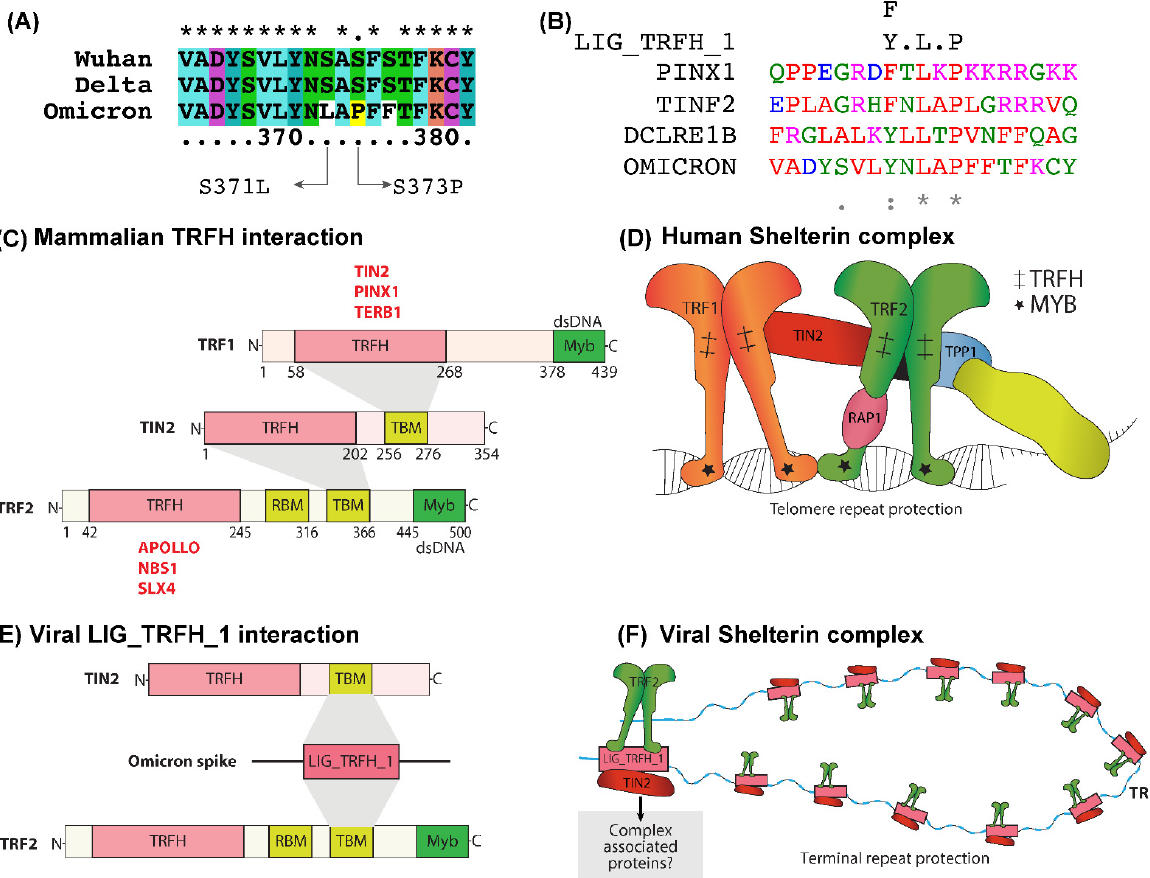
Figure 2. Structure and interaction networks of shelterin ‐ complex ‐ associated proteins. ( A ) Snapshot of the multiple sequence alignment of spike proteins from Wuhan, Delta, and Omicron, along with the specific mutations in the Omicron that led to the emergence of the novel LIG_TRFH_1 motif. ( B ) Snapshot of the multiple sequence alignment of spike protein from Omicron variant along with human proteins that contain this specific motif. ( C ) Domain organization of human TRF1, TRF2, and TIN2. ( D ) Interaction of the human ‐ telomere ‐ associated proteins. TIN2 bridges TRF1 and TRF2 that bind to the ds telomeric DNA. ( E ) Omicron SLiM LIG_TRFH_1 interacts with cellular TRF2 and TIN2. ( F ) LIG_TRFH_1 interaction with shelterin proteins protects the viral terminal repeats. Other proteins involved in the protective complex must be identified. TR ‐ terminal repeats. Viral infection can also induce DNA damage and evoke the host DDR, and several studies reported that the progression of SARS ‐ CoV ‐ 2 severity is associated with decreased telomere length [13,14]. A study on African green monkey kidney cells (Vero E6) showed that SARS ‐ CoV ‐ 2 infection could trigger DNA damage response (DDR) and impact telomeric stability [10,15]. We assumed, analogously to cellular TRFH, the identified viral LIG_TRFH_1 could interact with TRF2 and TIN2 proteins. A possible interaction between LIG_TRFH_1, and TRF2 and TIN2 is presented in Figure 2E. TIN2 is the shelterin complex’s central hub that interacts with TRF1, TRF2, and TPP1, and promotes the assembly of an intact shelterin complex that protects the telomeric repeats. TRF2 participates in t ‐ loop formation and protects telomeres from DDR pathways [16]. We presumed that, in Omicron ‐ infected cells, this interaction might favor the assembly of the other shelterin components at the viral terminal repeats, and thus establish a protective complex that can effectively suppress the cellular DDR, as shown in